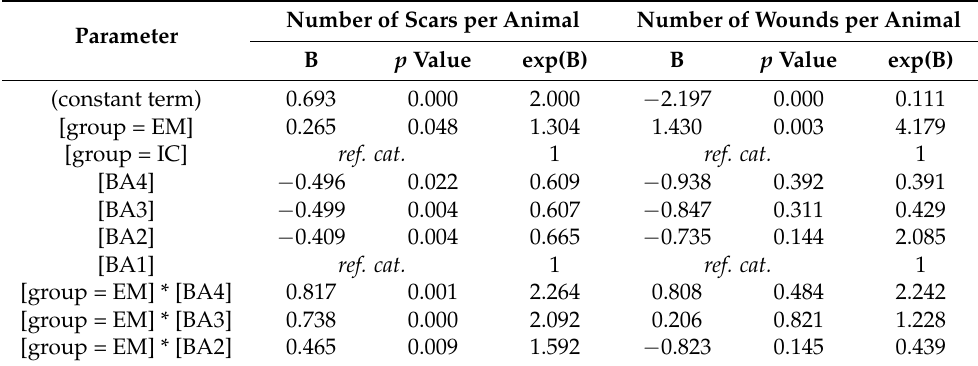
Table 1. Probability distribution (Poisson). Left side dependent variable: number of scars; right side dependent variable: number of wounds.